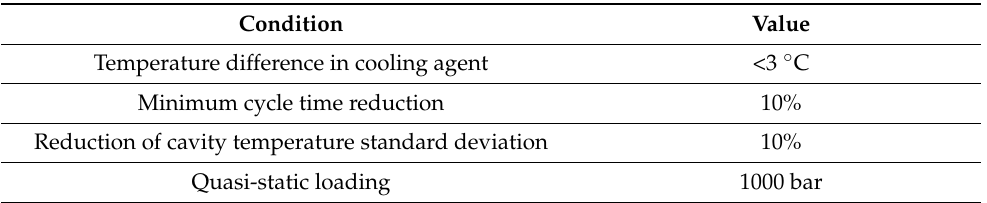
Table 2. Aims and boundary conditions for the performed